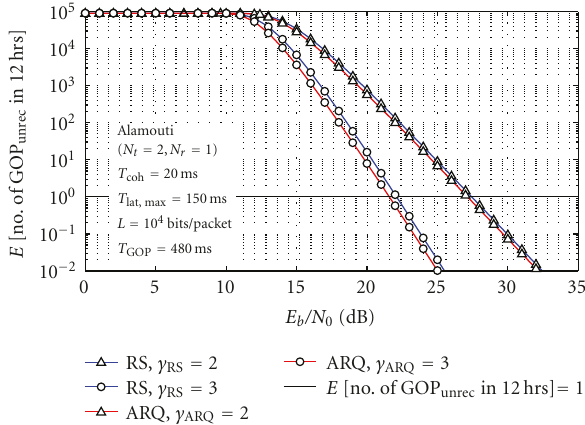
Figure 18: Average number of GOPs a ff ected by unrecoverable packet loss in 12 hours, RS versus ARQ (Alamouti, N r =